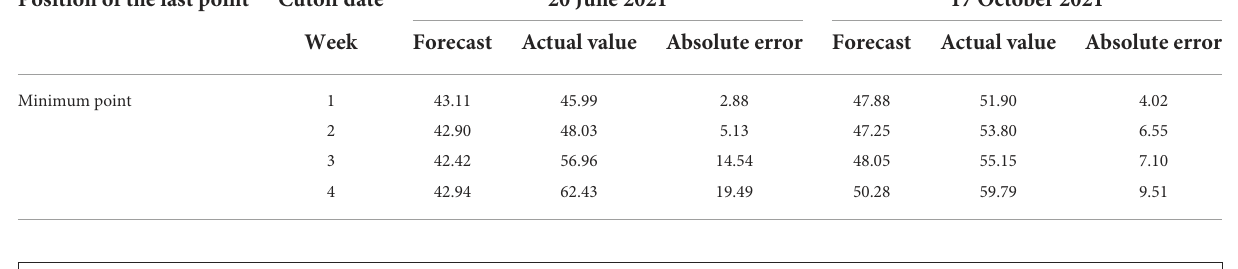
TABLE 8 Forecast result when the last point is at the minimum point. Position of the last point